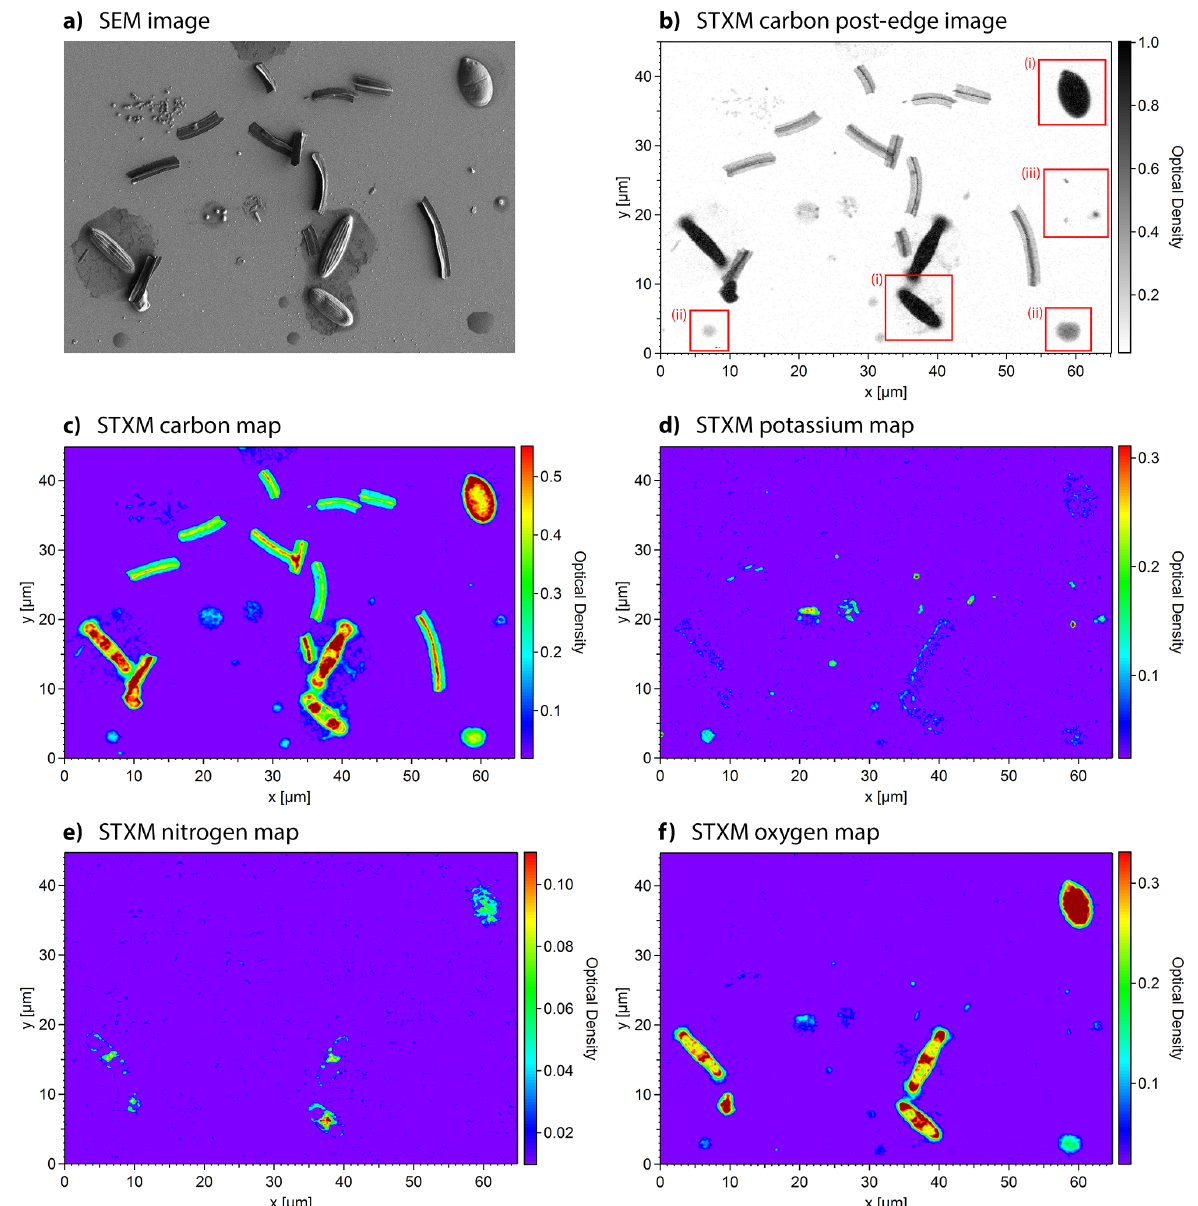
Figure 33. Microscopic images of aerosol particles during rainy season. (a) SEM images of representative region. (b) STXM carbon post- edge image (293 eV) and (c–f) STXM elemental maps of same region. The particle types are indicated in panel (b) : primary biological aerosol particles (region i), droplet-like SOA particles (region ii), and potassium-rich biogenic salts (region